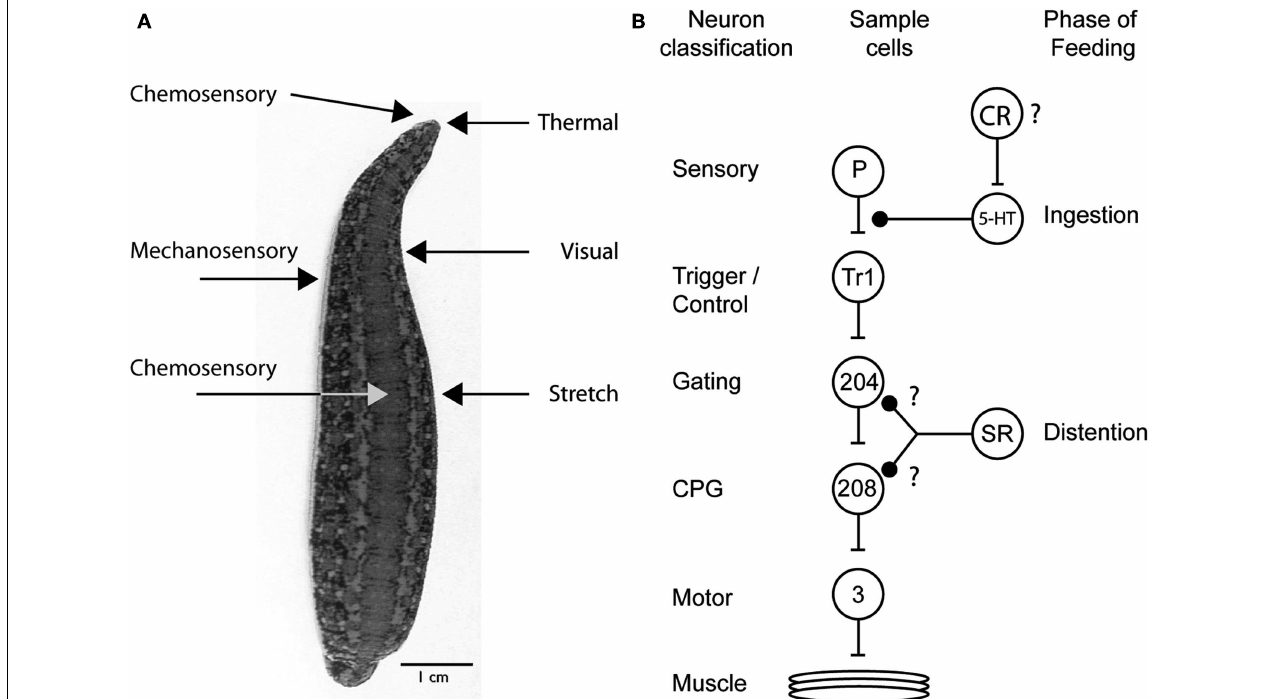
FIGURE 4 | Sensory receptors and targets involved in the leech’s decision to feed. (A) Sensory receptors implicated in feeding based on behavioral experimentation. Chemosensory and thermal receptors on the dorsal lip are used to determine whether to attempt to feed on a potential food source. Additional chemosensory receptors sample the food in the gut and determine whether feeding will continue or cease.Visual and mechanosensory receptors located in the body wall allow the leech to orient into water waves to find their point of origin and thus likely prey. Stretch receptors in the gut of the leech serve to terminate feeding once a full meal has been ingested. (B) Diagram summarizing the multiple ways that leech feeding is known to inhibit the swimming circuit.The circles represent cell populations; the letters and numbers inside the circles indicate one identified neuron from that population type.The lines ending in bars represent excitatory connections, and those ending in solid black circles represent inhibitory connections.The diagram shows the excitatory,